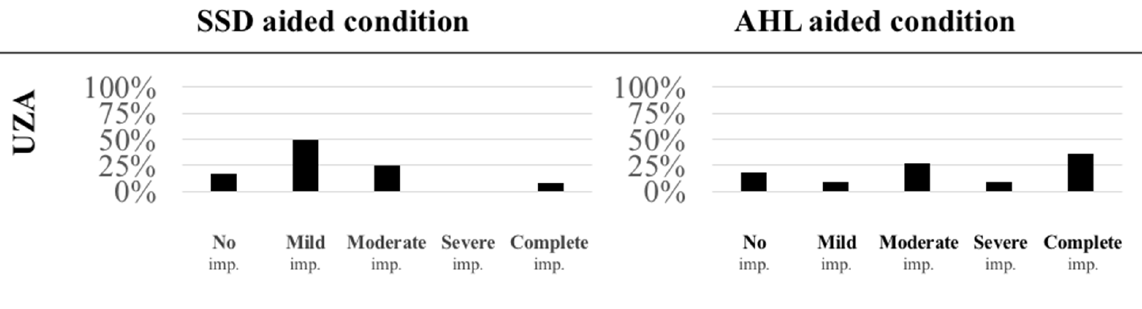
Hospital (UZA) for two different listener groups, a single-sided deaf group (SSD) and a group with